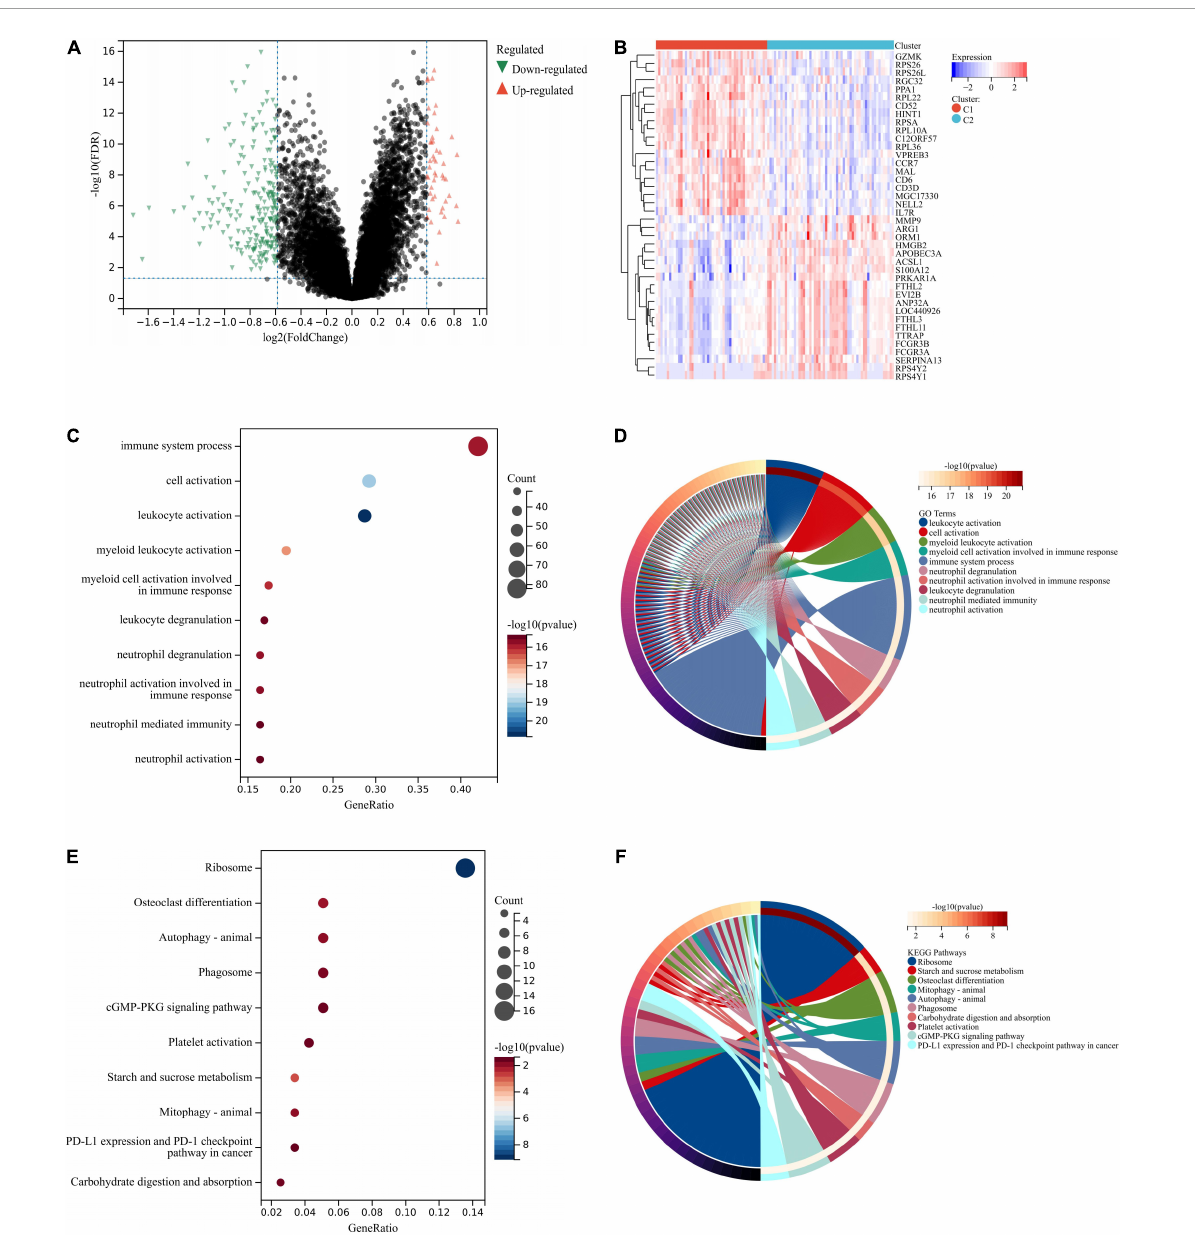
FIGURE10 Functional analysis between two different subtypes. The DEGs were shown by volcano plot (A) and heat map (B) between two subtypes. (C) GO enrichment analysis was performed on the DEGs. GO terms are represented on the y-axis, gene ratios are shown on the x-axis, circle sizes refer to gene numbers, and colors represent p -values. (D) GO enrichment analysis of the DEGs. Different colors represent various significant GO terms and related enriched genes. (E) KEGG pathway analysis was performed on the DEGs. The y-axis represents different pathways, gene ratios enriched in relative pathways by the x-axis, circles represent gene numbers, and colors represent p -values. (F) KEGG pathway analysis of the DEGs. Different colors represent various significant pathways and related enriched genes. DEGs, differentially expressed genes; KEGG, Kyoto Encyclopedia of Genes and Genomes; GO, Gene